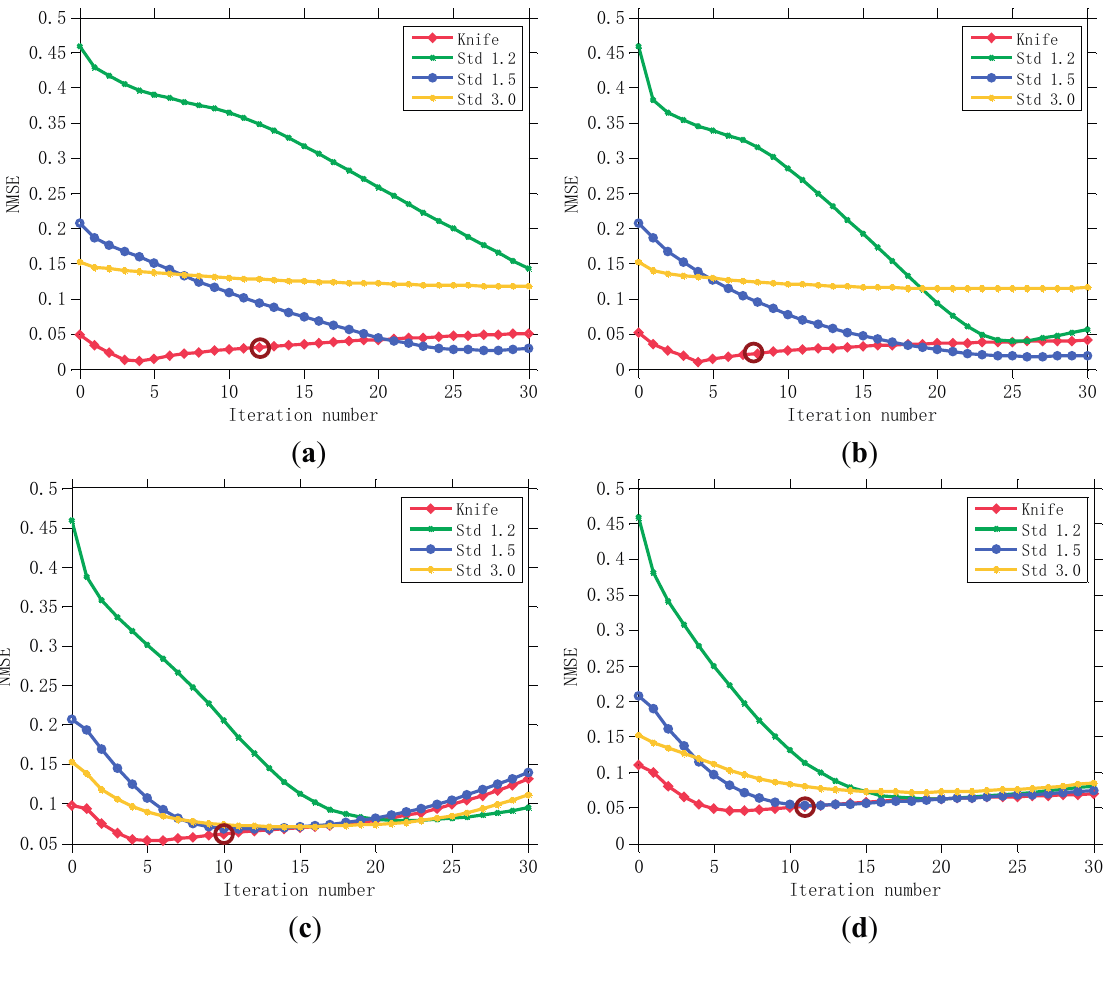
Figure 14. Evolution of NMSE with iterations using different initializations. The AM framework is initialized with the proposed PSF estimation method and with manually selected PSF initializations (a 5 × 5 truncated Gaussian PSF with a standard deviation of 1.2, 1.5, and 3.0), represented by “Knife,” “Std 1.2,” “Std 1.5,” and “Std 3.0,” respectively. Stopping positions utilizing the proposed automatic stopping strategy are marked by circles. ( a – d ) correspond to the iterations of Figures 5–8a,